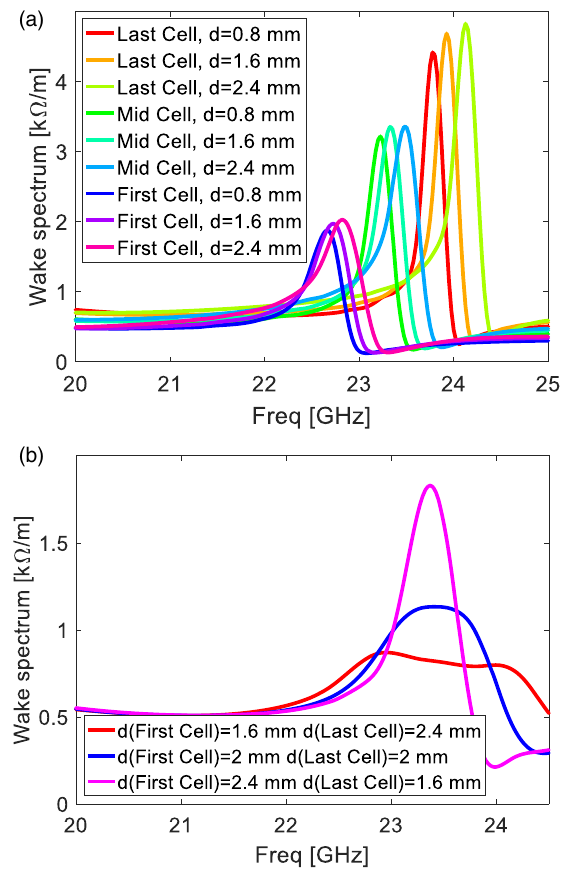
FIG. 11. Detuning the 23 GHz mode ( d is the iris thickness defined in Fig. 6): (a) Spectrum ( Wx ) of single cell; (b) spectrum ( Wx ) of the full